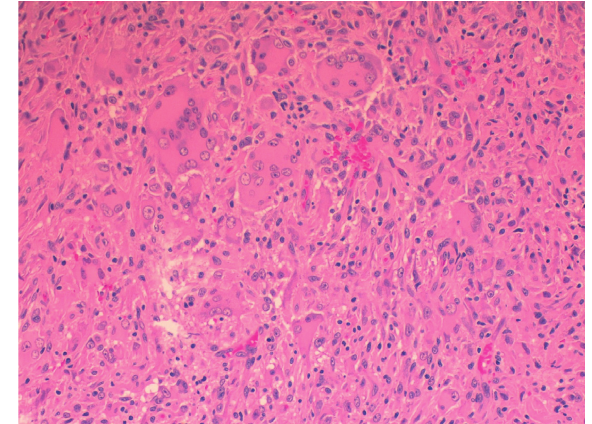
Figure 2: Mixed proliferation with elongated cells and multinu- cleated histiocytic-like cells of large eosinophilic cytoplasms with mild lymphocyte response (H-E × 20).